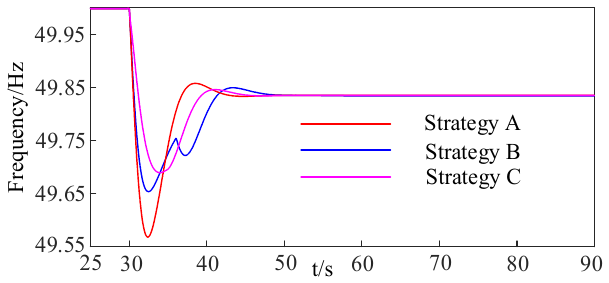
Figure 8. variation of system frequency under different control strategies. Figure 8. Variation of system frequency under different control strategies.